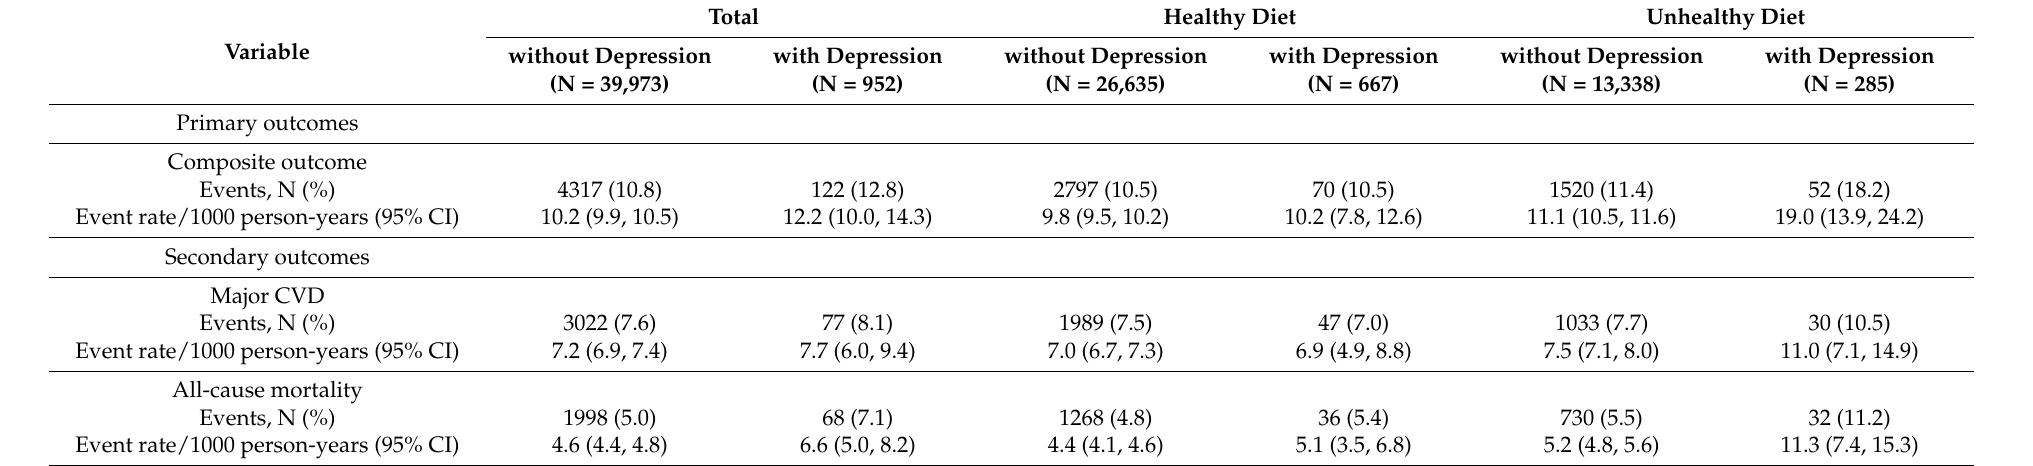
Table 2. Event rates grouped by depression and